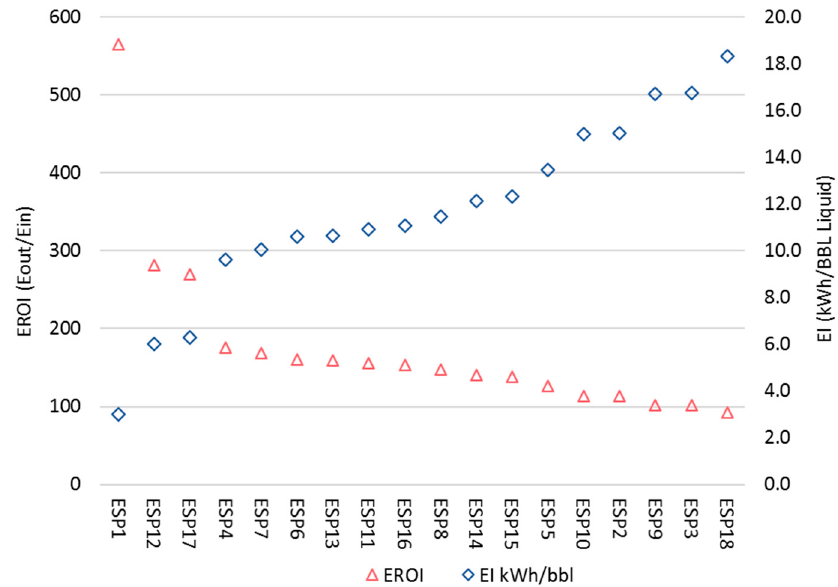
Figure 7. EROI-lifting and energy intensity for 18 ESP systems.